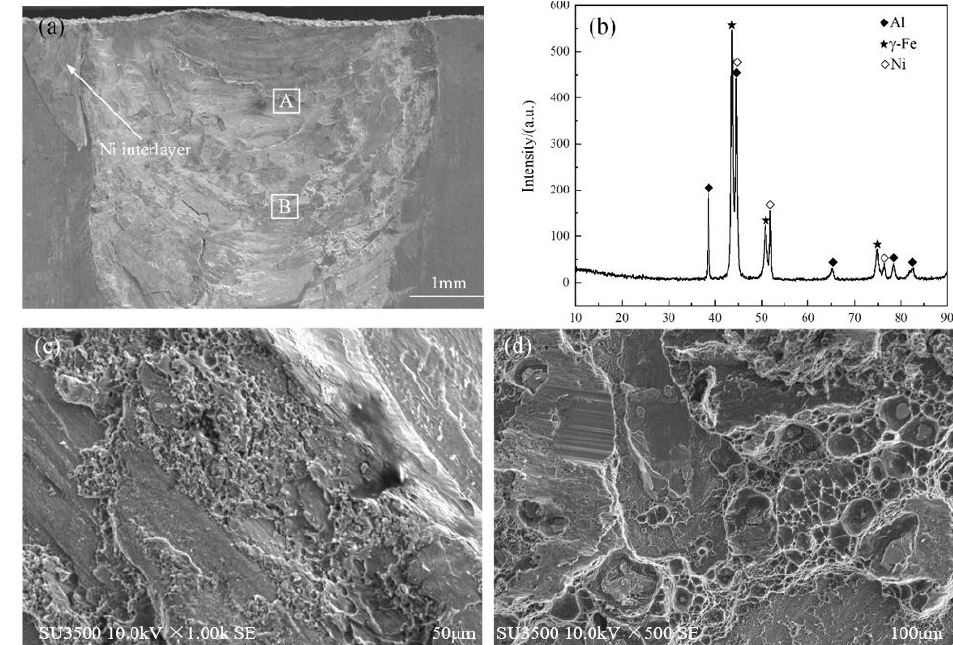
Figure 10. Characteristics of the fracture surface at the steel side of the joint at 800 rpm: ( a ) fracture morphology and ( b ) XRD analysis; ( c , d ) enlarged views of regions A and B marked in Figure